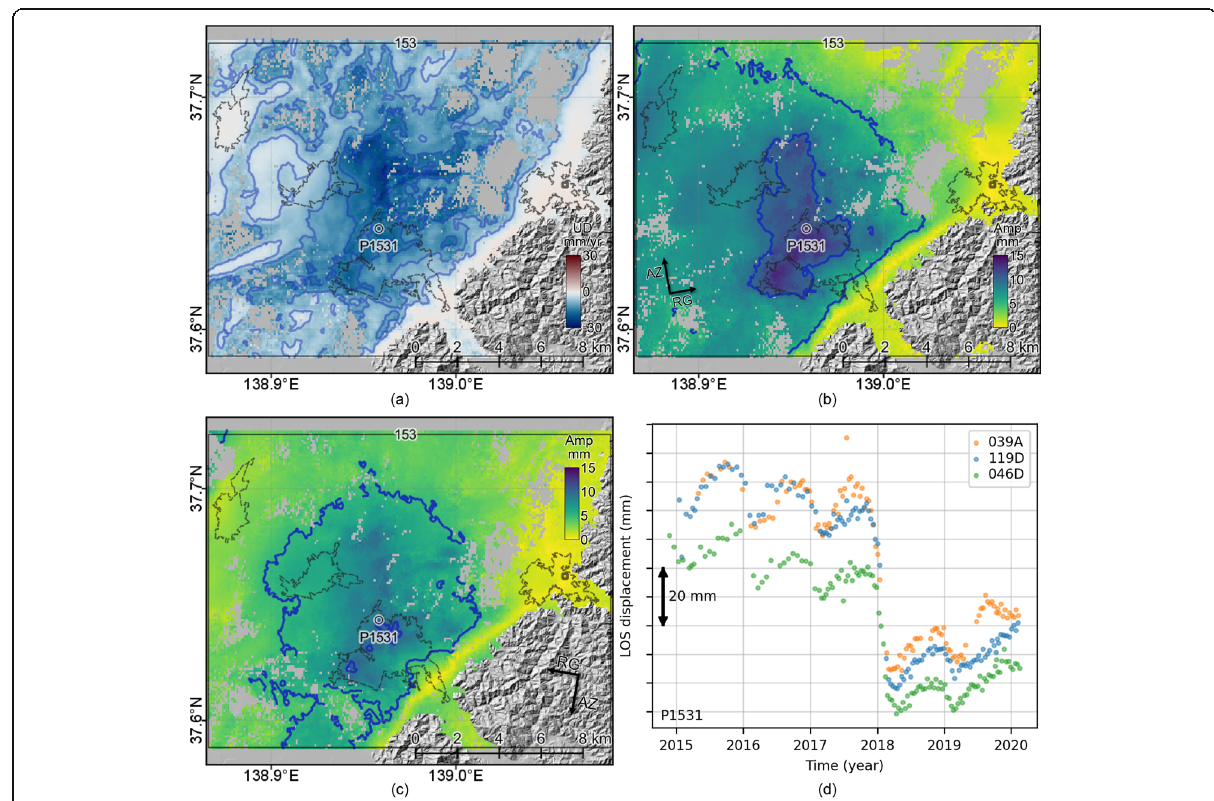
Fig. 11 a Vertical deformation velocities in Sanjo (ID: 153). The black lines denote the outlines of the DID. The interval of the blue (subsidence) contour lines is 5 mm/year without the 0 mm/year lines. The black square denotes the reference point. b Amplitudes of the annual LOS fluctuation from the ascending 039A_05193_040711. The interval of the contour lines is 5 mm. c Amplitudes from the descending